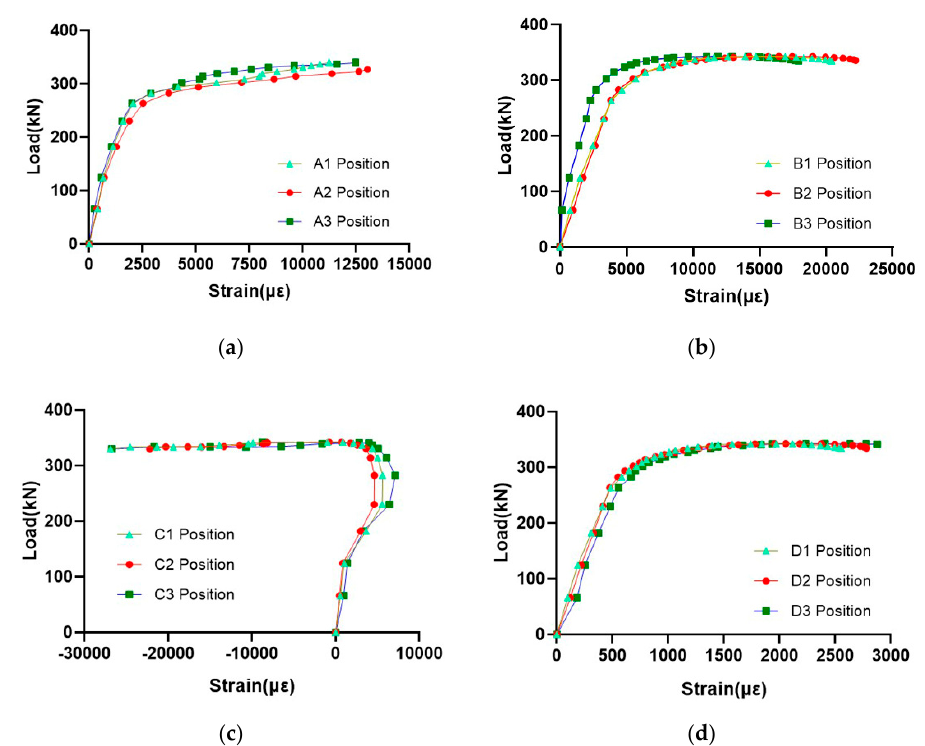
Figure 16. Load – strain curve of different measuring points: ( a ) point a; ( b ) point b; ( c ) point c; ( d ) point d.